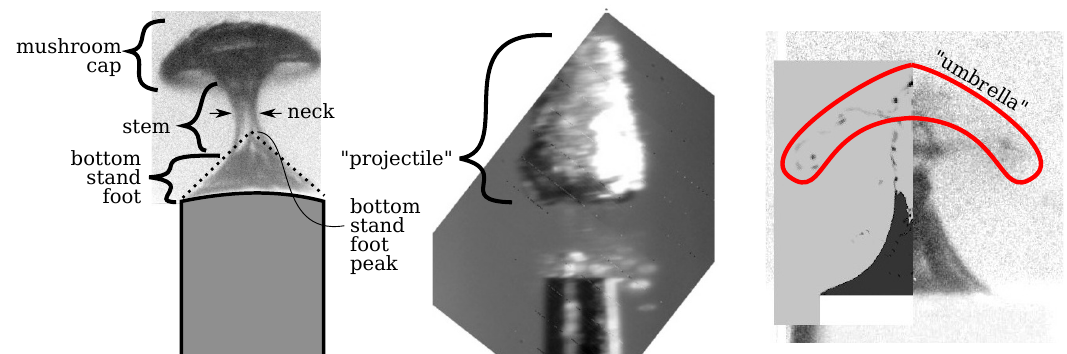
Figure 7. Terminology for mushroom-shaped bubbles.